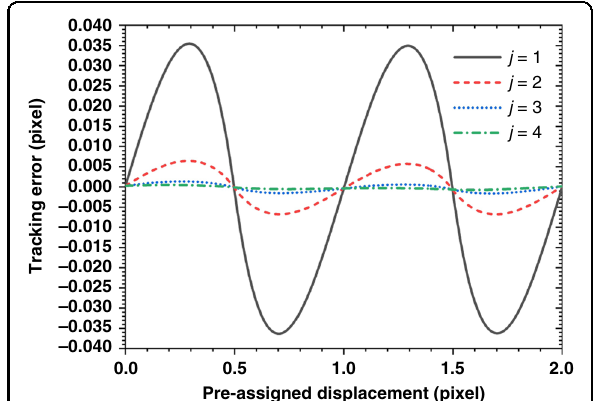
Fig. 3 Calculation (tracking) error of the INCC sub-pixel registration algorithms for rigid body translation images over a 0 – 2 pixel displacement range. The tracking error is reduced signi fi cantly by increasing the iteration number j from 1 to